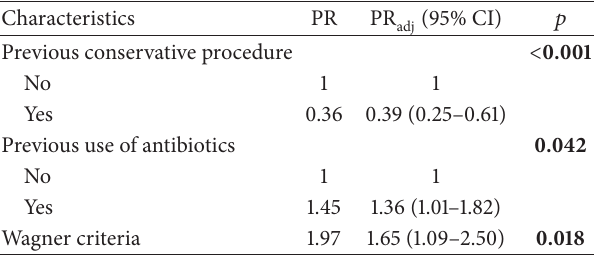
Table 6: Wagner criteria. Estimate of the prevalence ratio of the outcome to foot amputation in patients with diabetes using the Cox multiple regression